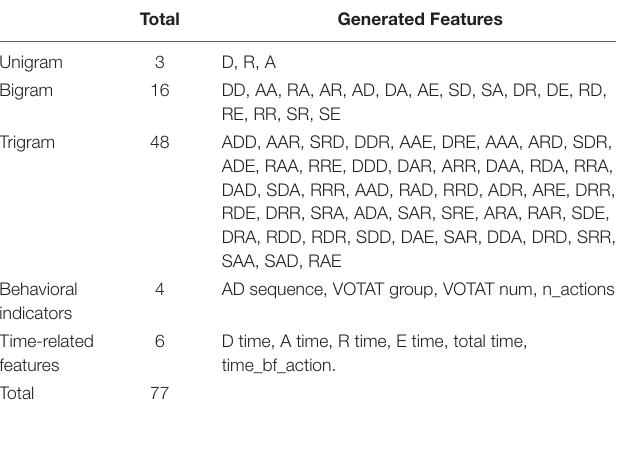
TABLE 5 | Variables generated from process data of climate control task